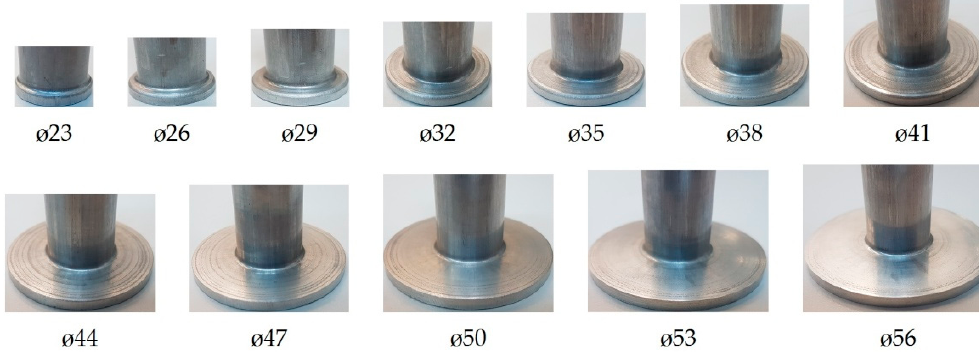
Figure 4. Changes in flange shape in incremental radial extrusion.